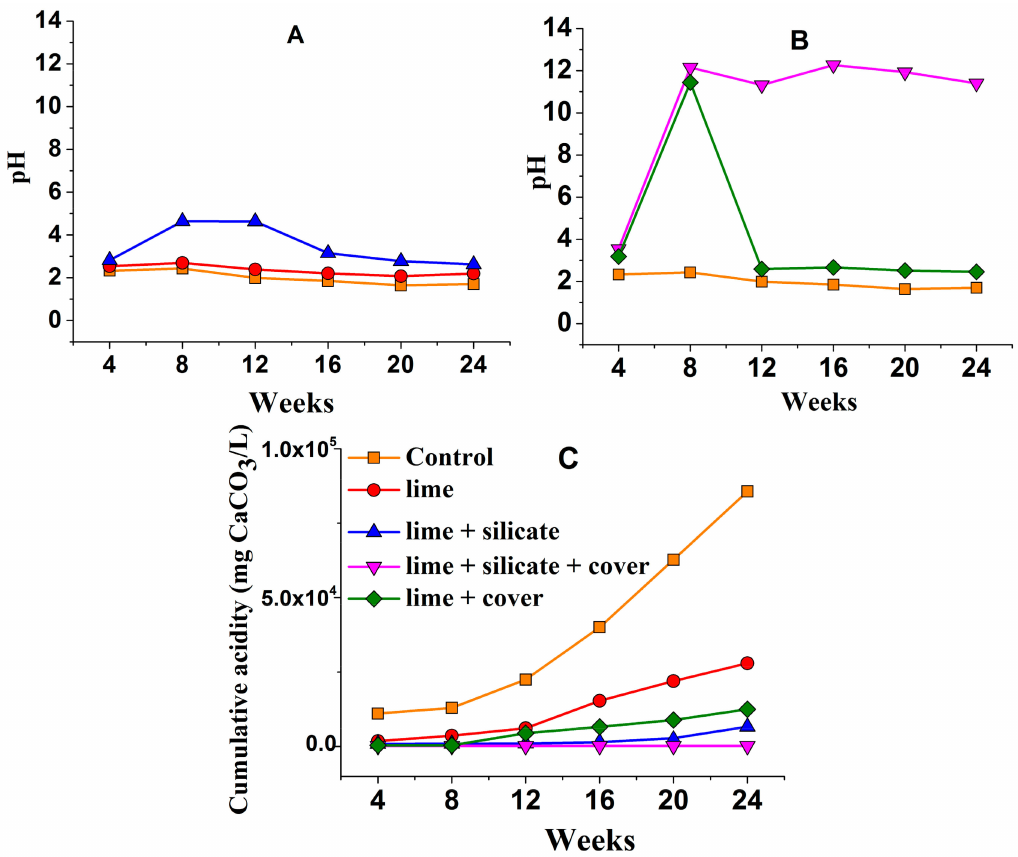
Figure 1. KLC leachate pH and cumulative acidity profiles during 24 weeks of operation (see Table 1 for details of each KLC). Figure legend in ( C ) is common to ( A , B